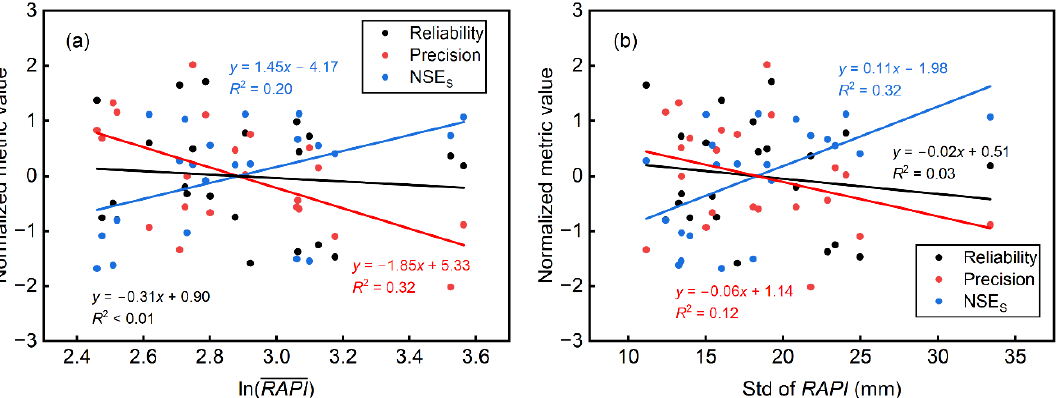
Figure 11. Scatter plot of normalized predictive performance metric values: normalized metric values as a function of ( a ) the natural logarithm of the mean optimal RAPI and ( b ) the standard deviation of optimal RAPI for each flood event. Linear trends and corresponding R-squared value.